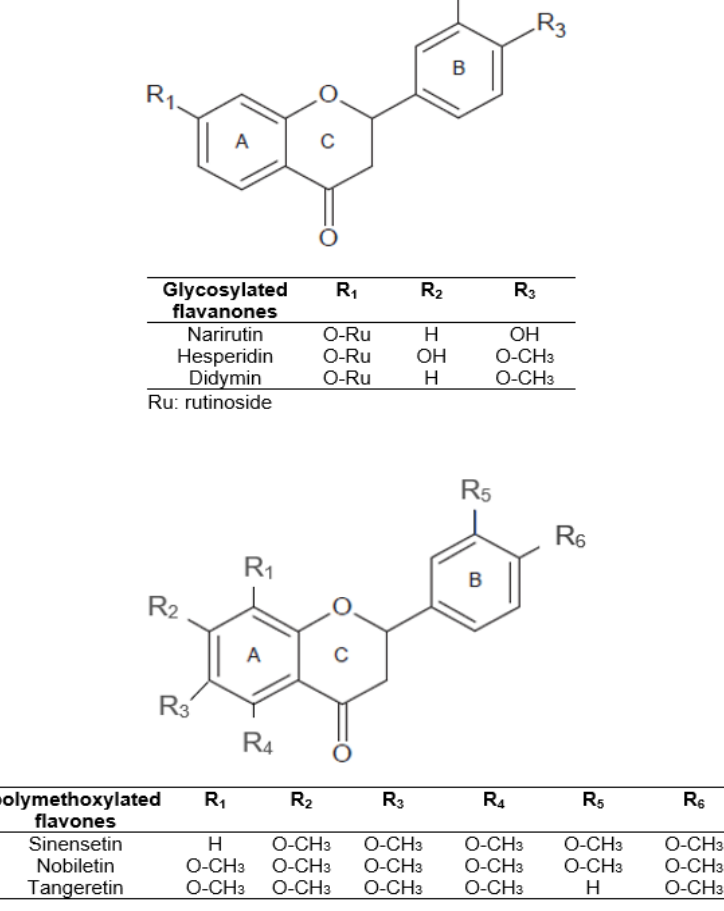
Figure 1. Structure of the main citrus peel flavonoids.